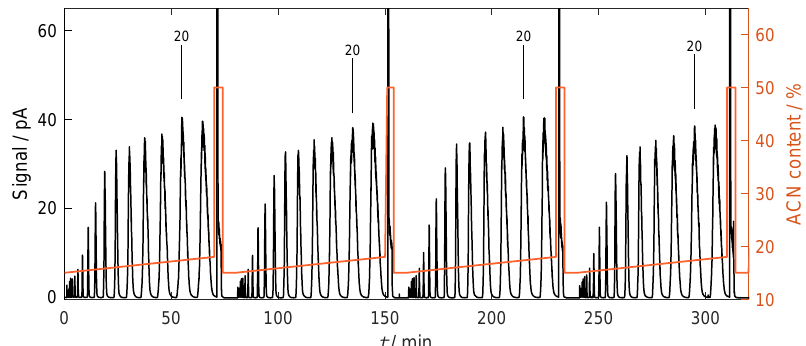
Figure 10. Experiment with four consecutively applied larger injections performed under linear gradient conditions. Conditions as in Figure 9, but injected concentration increased to 250